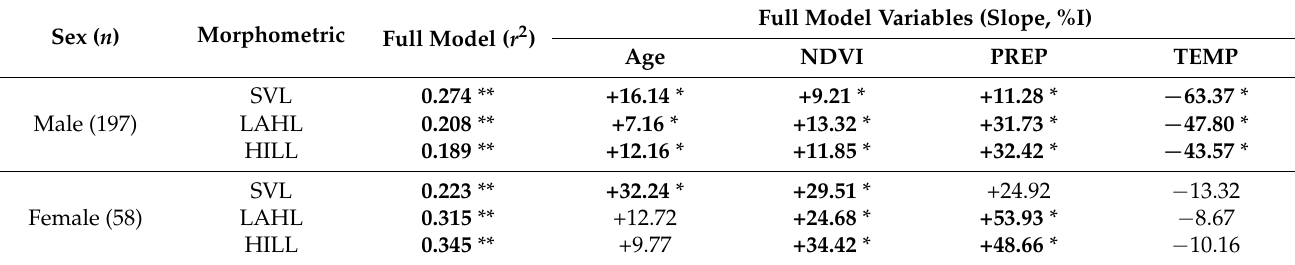
Table 2. Summary of multiple regression and hierarchical partitioning results for biological and environmental effects on Rana kukunoris morphometrics. Statistics were calculated with multiple regression models for age, normalized difference vegetation index (NDVI), precipitation (PREP), and temperature (TEMP). For multiple regression models, explained variance is given as the adjusted R square value ( r 2 ). For the variables within the full regression models, explained variance is given as a percentage of independence (%I) based on hierarchical partitioning, with +/ − indicating the direction of the relationship.